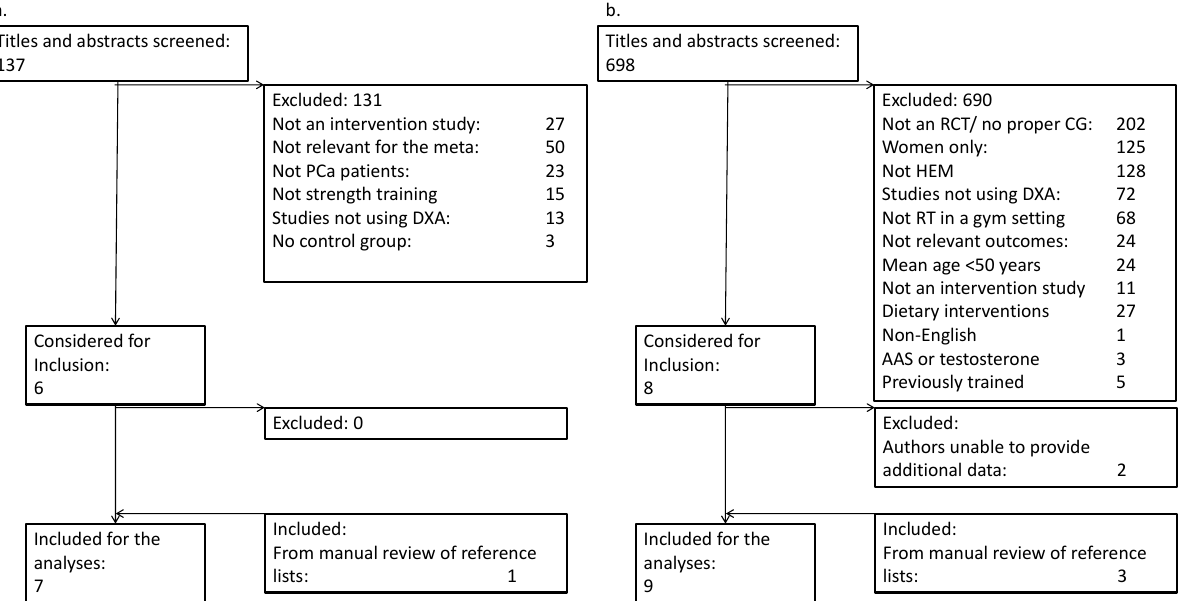
Figure 1. PRISMA flow diagram for ( a. ) prostate cancer patients and ( b. ) healthy elderly men. The search strategy yielded 698 publications in HEM, of which 690 were excluded (Figure 1b). Major reasons for exclusions were not a randomized controlled design ( n = 213), studies in other cohorts than HEM ( n = 128), and studies in women ( n = 125). Addi- tional reasons are listed in Figure 1b. For studies including both men and women, the corresponding authors were contacted to request separate results for male participants. In eight cases of this nature, we were able to obtain separate results for males for six